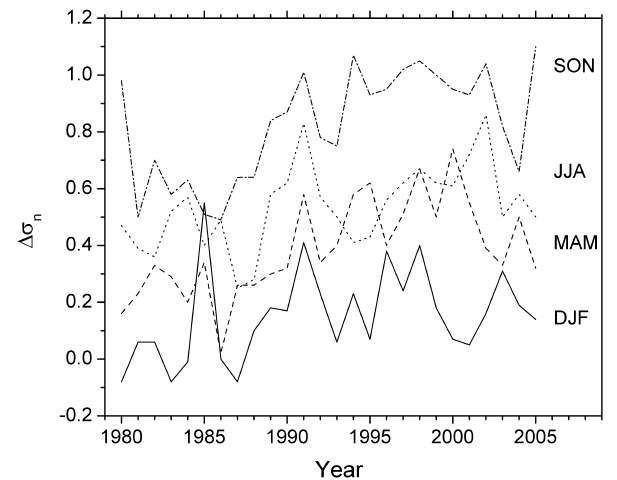
Fig. 11. Long term trend coefficients ( B from Eq. 2) for the zonal- meridional standard deviation difference, which was divided by the magnitude of the prevailing wind, for each month of the year, and for 2 different period